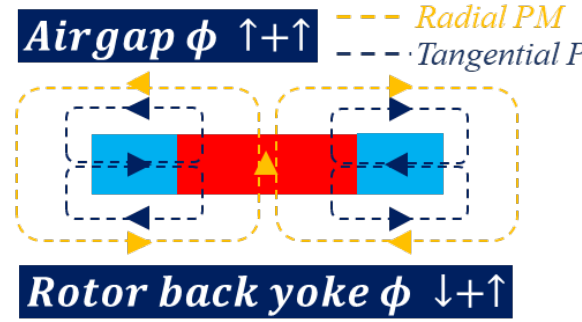
Figure 1. Halbach array principle.